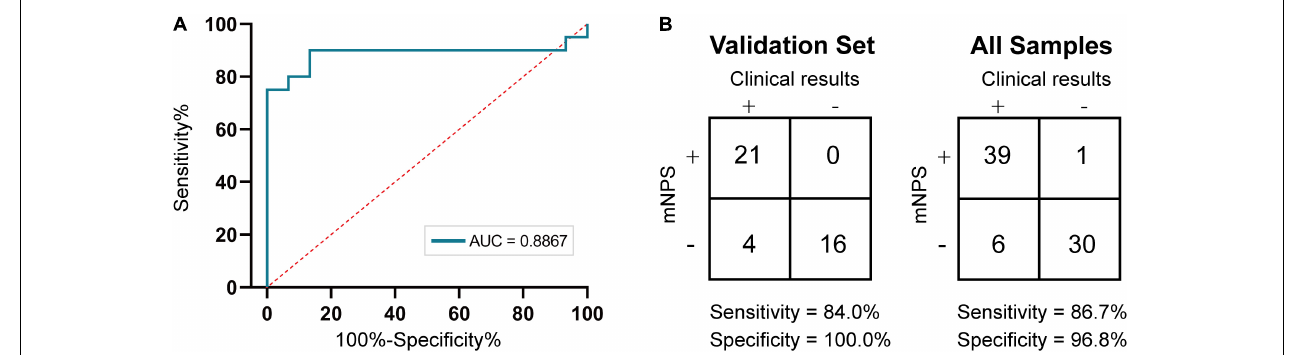
FIGURE 4 | Accuracy of mNPS testing. (A) ROC curve of nanopore sequencing of training set based on culture. Plotted are mNPS test sensitivities and specificities, relative to the clinical urine culture, at RPM threshold values ranging from 0.04 to 91.24. (B) Contingency table for the training set ( n = 35 samples) and validation set ( n = 41 samples) of mNPS, respectively. The scoring system for determination of positive and negative results is listed in Supplementary Table 1